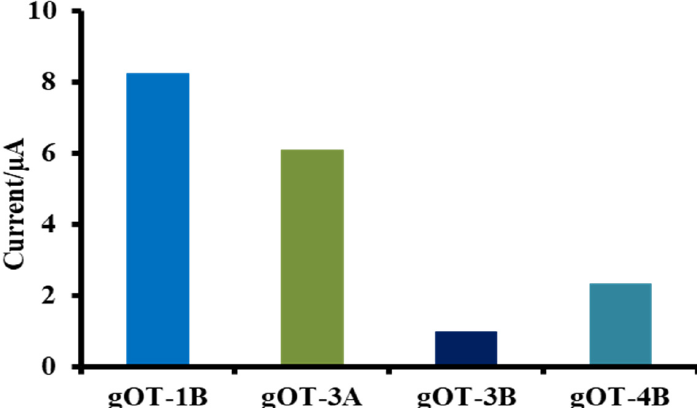
Figure A2. Electrochemical sensor signal response to oxytocin from four candidate aptamers is shown as a bar chart, verifying the strong affinity of gOT-1B.